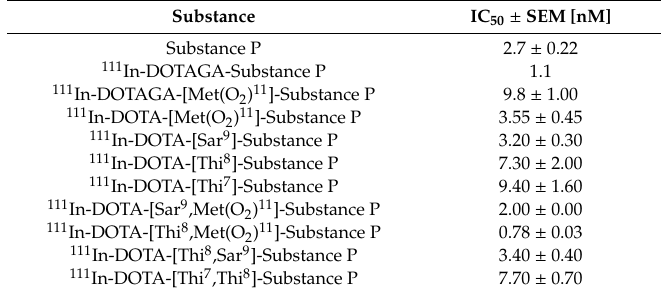
Table 2. The IC 50 values determined for SP and various radiobioconjugates based on SP analogues